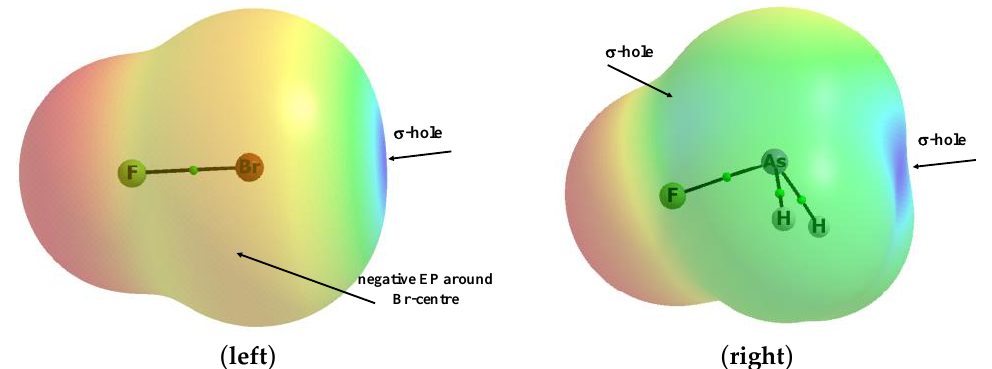
Figure 1. Electrostatic potential maps of the FBr ( left ) and AsFH 2 ( right ) species for the surfaces characterized by an electron density of 0.001 au.